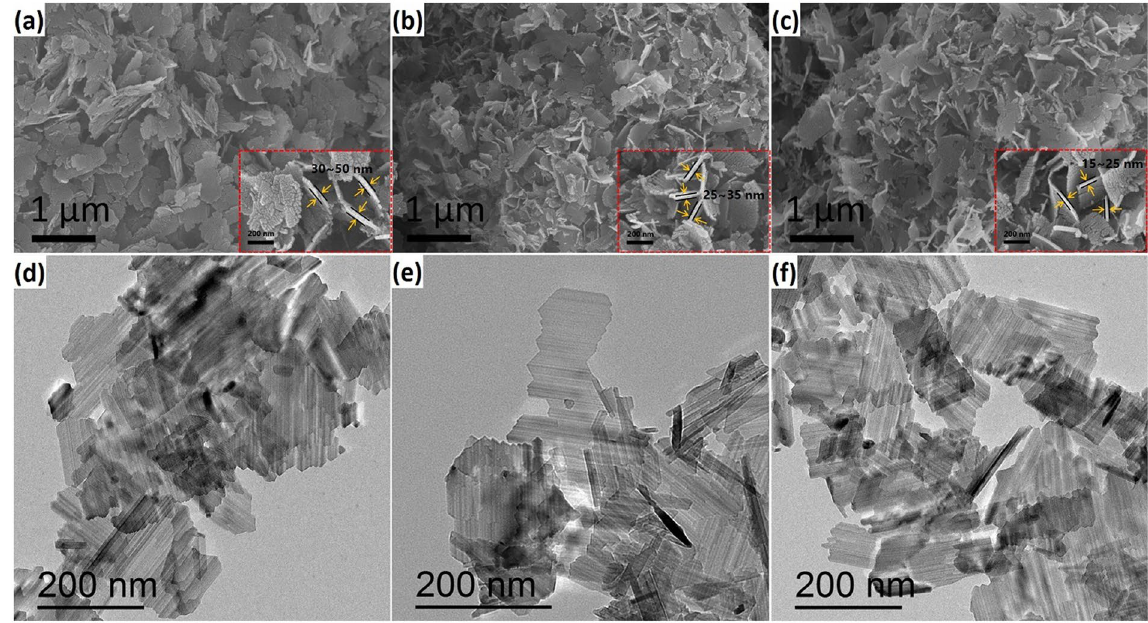
Figure 3. SEM and TEM images of ( a , d ) pure LTO, ( b , e ) LTO-RT and ( c , f )